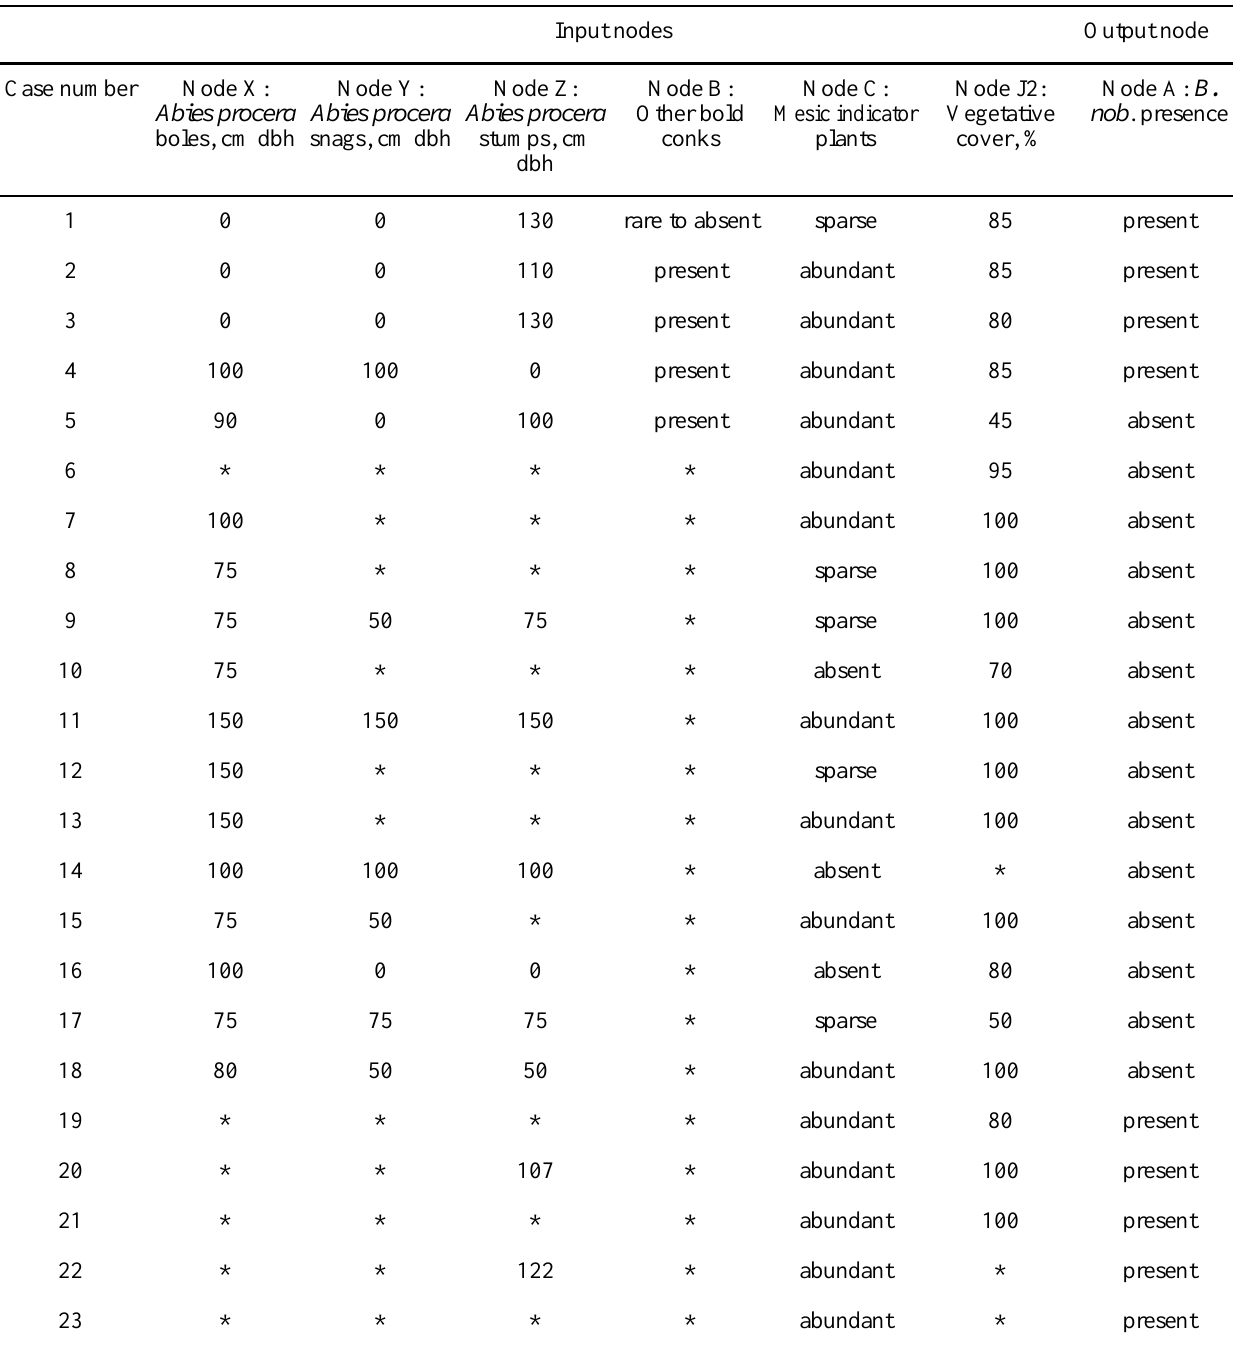
Table 1. Example of a case data table of a species from multiple surveys. Such data can be used to induce an initial network structure or to refine probabilities of relations in an existing network. Column headings refer to case number, and input and output nodes in the model for the rare fungus Bridgeoporus nobilissimus (B. nob.; Fig. 3a). * = missing data. (Data sources: T. O’Dell and T. Dreisbach, personal communication